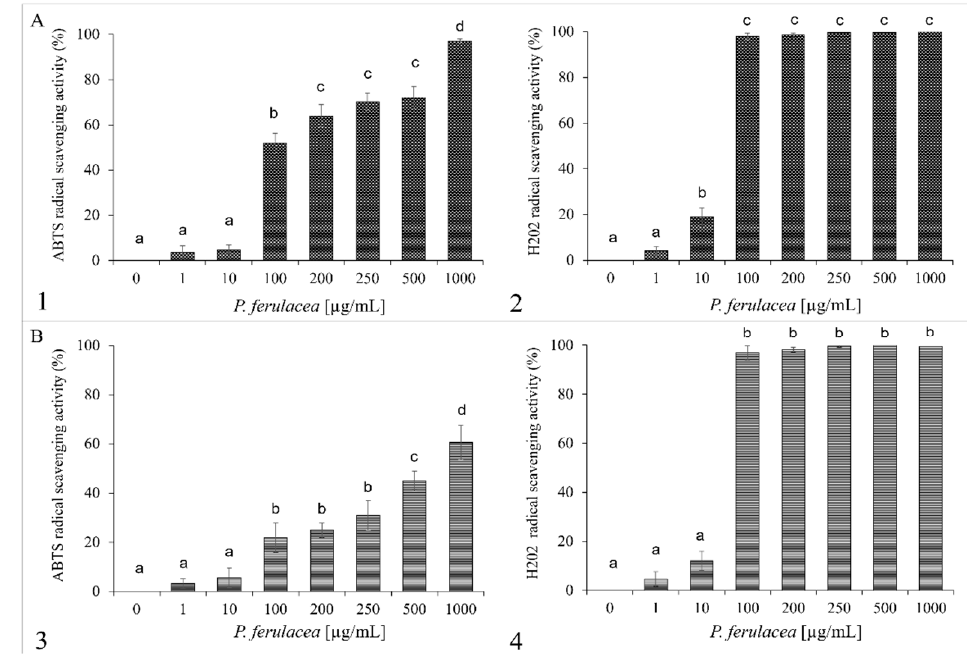
Figure 2. Antioxidant activity of P. ferulacea flower oil ( A ) and leaf oil ( B ). ABTS radical scavenging activity (1, 3) was measured after 10 min of incubation and reported as % of ABTS removed, with respect to the control. Hydrogen peroxide scavenging activity (2, 4) was measured after 30 min of incubation and reported as % of H 2 O 2 removed, with respect to the control. Data were presented as mean and standard error and they were analyzed with a paired t -test. Bars not accompanied by the same letter were significantly different at p < 0.05. Table 3. IC 50 : concentration that inhibited 50% of the free radicals; ABTS: 2,20-azino-bis (3-ethyl- benzothiazoline-6-sulfonic acid); H 2 O 2 : hydrogen peroxide. Positive control was represented by ascorbic acid for ABTS; and resveratrol for H 2 O 2 .